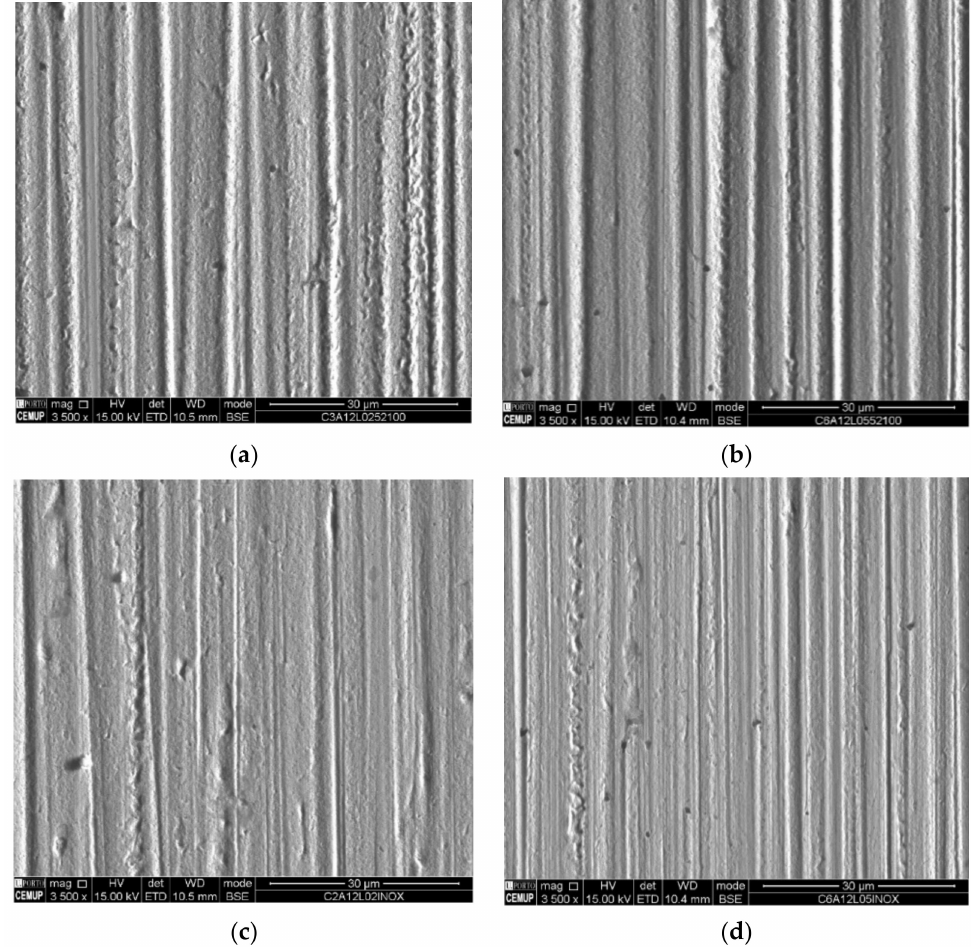
Figure 15. Evolution of the groove marks visible on the craters by SEM for the alumina (1 µ m) abrasive: ( a ) AISI 52100; load 0.2 N, ( b ) AISI 52100; load 0.5 N, ( c ) SS AISI 304; load 0.2 N, ( d ) SS AISI 304; load 0.5